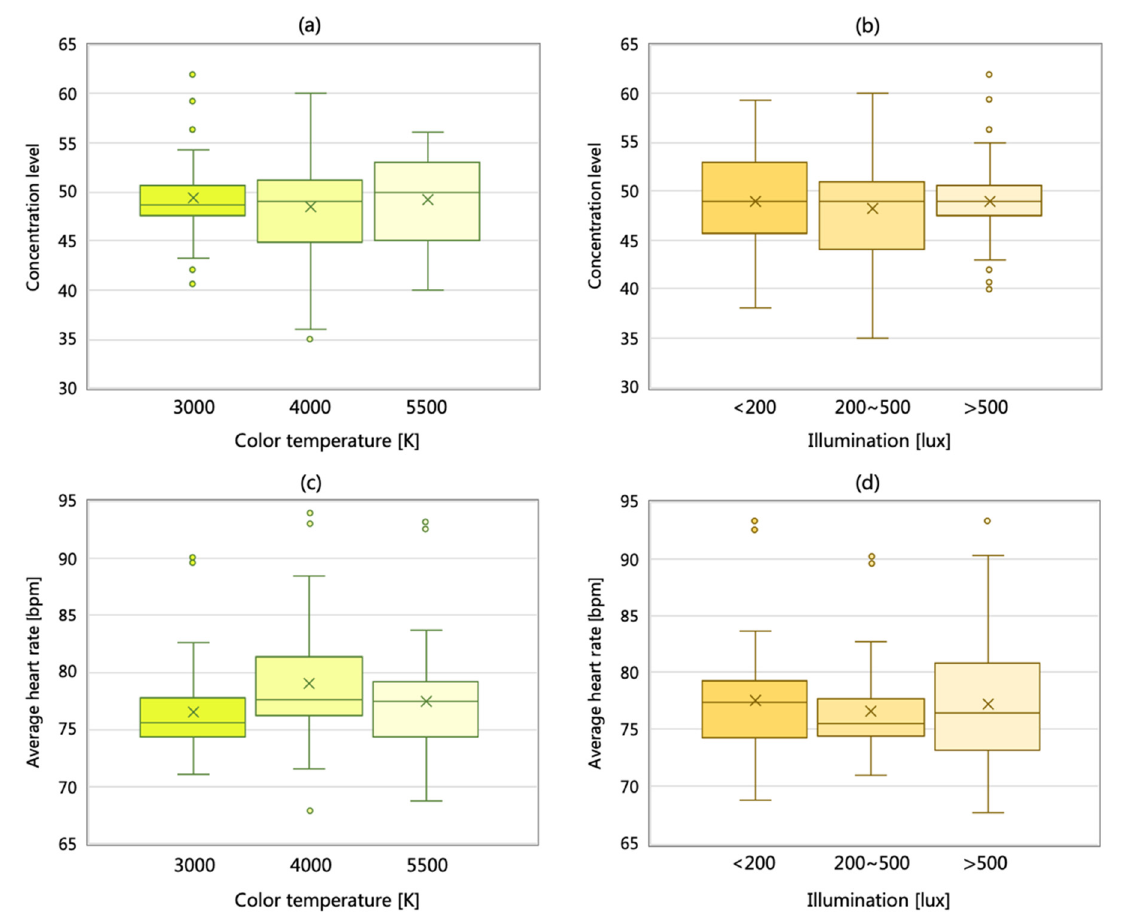
Figure 5. Concentration level and average heart rate of different CCTs and illumination: ( a ) The difference in brain waves under different CCTs; ( b ) The difference in brain waves under different illumination; ( c ) The heart rate of subjects under different CCTs; ( d ) The heart rate of subjects under different illumination.